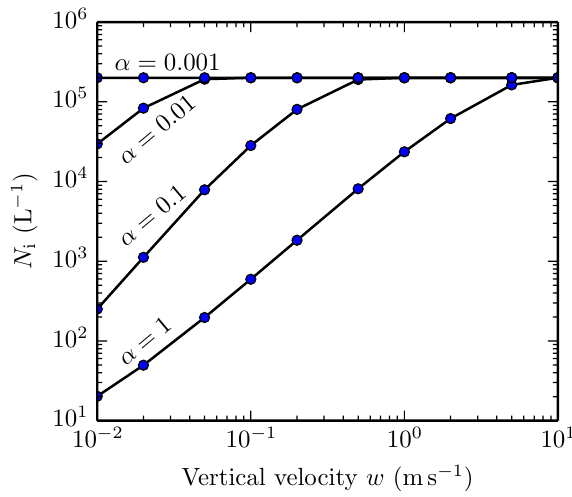
Figure 1. Power spectrum of the raw and filtered temperature per- turbation time series derived from the balloon vertical displace- ments.